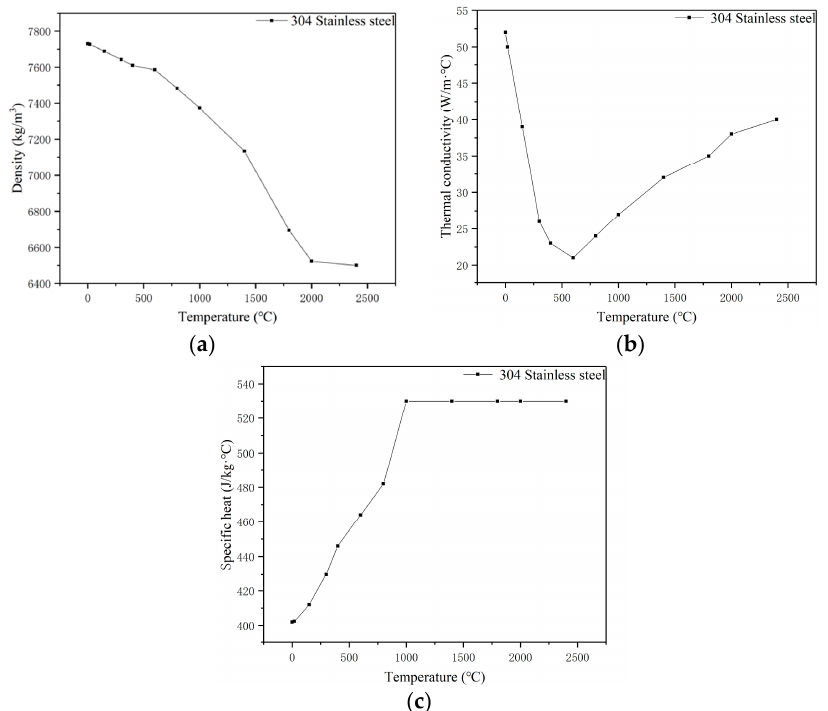
Figure 2. Material properties of the 304 stainless steel: ( a ) density; ( b ) thermal conductivity; and ( c ) specific heat.